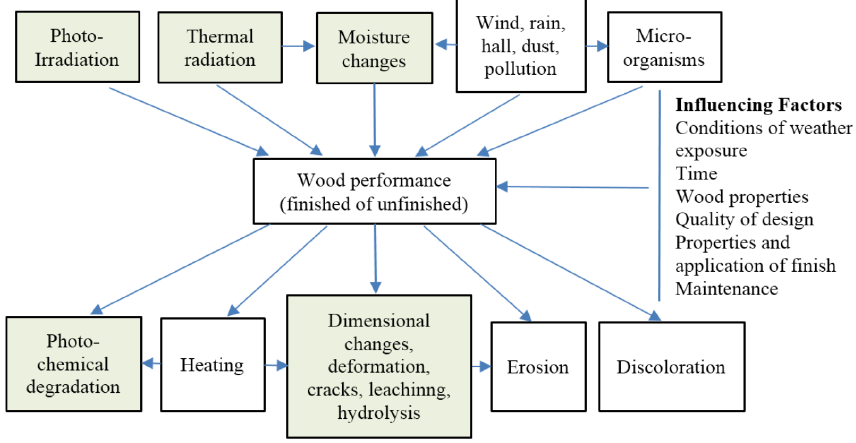
Figure 3. Elements in the weathering process [8].